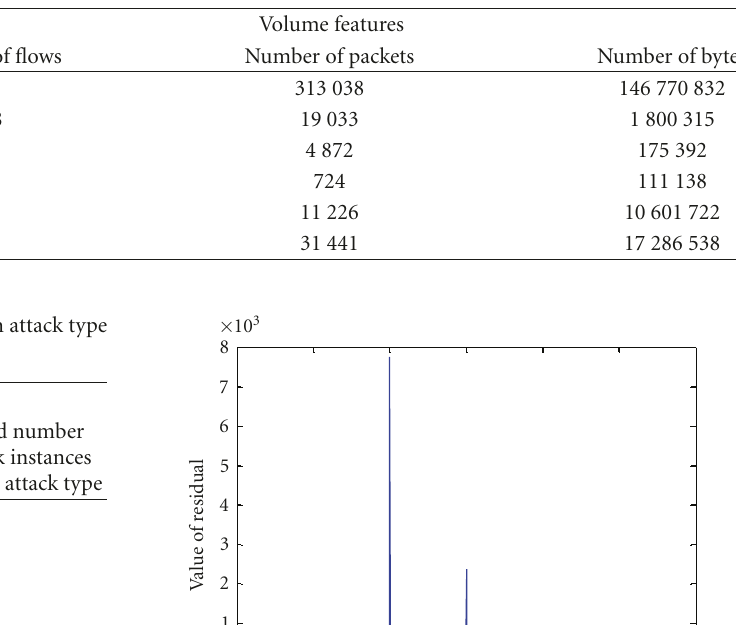
Table 9: Descriptions on attacks identified on the third day in Fred-eZone.